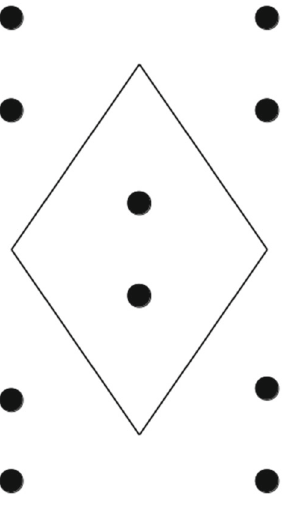
Fig. 1 Location of atomic strings along the (cid:4) 110 (cid:5) axis of a silicon